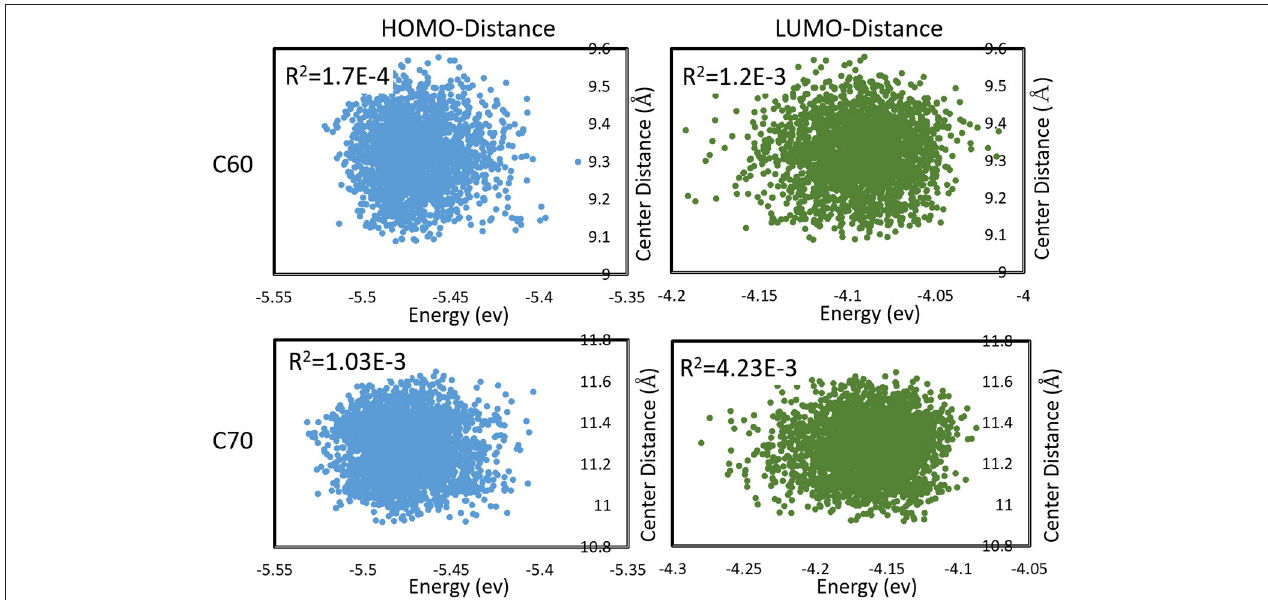
FIGURE 5 | Correlations between HOMO, LUMO energies, and intermolecular distances (between centers of mass) during molecular dynamics in C60 and C70. Pearson R 2 coefficients are also shown.